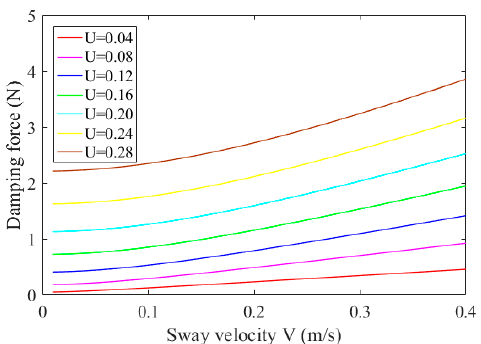
Figure 7. The curve of damping force in surge direction changing with disturbance velocity (sway velocity) under different surge velocities.